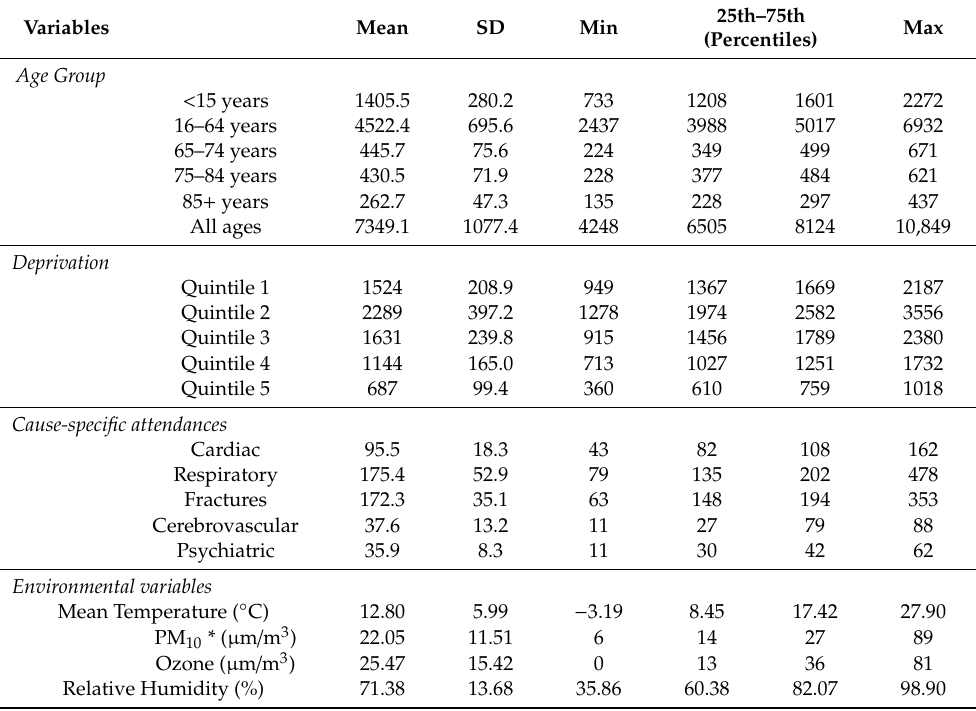
Table 1. Descriptive statistics of the Emergency Department data, meteorological factors and air pollutants in Greater London (GL) between 2007 and 2012.